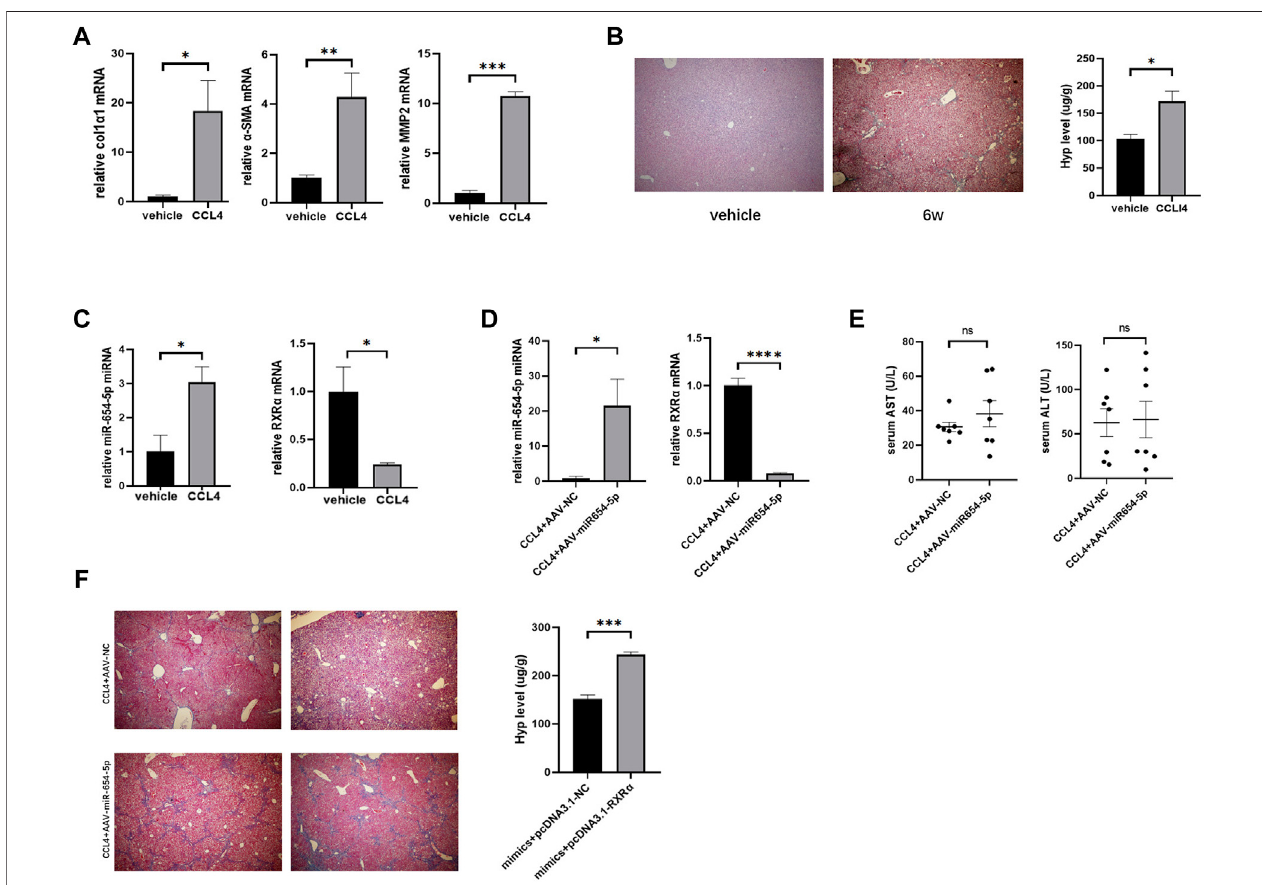
FIGURE 6| MiR-654-5p expression level is increased causing an aggravating effect in CCl4-induced mouse LF, owing to RXR α targeting. (A) col1 α 1, α -SMA, and MMP2 mRNA expression levels in the livers of CCl 4 -treated mice versus vehicle. Quantitative polymerase chain reaction analyses were performed to quantify mRNA expression levels, with β -actin as a loading control (B) After treating with olive oil control (vehicle) or CCl4 for 6 weeks, Masson ’ s trichrome images (40× magni fi cation) and hydroxyproline measurement were used to evaluate liver fi brosis. (C) MiR-654-5p and RXR α levels in liver tissues. U6 was used as a loading control for miR- 654-5p (D) ExpressionlevelsofmiR-654-5pandRXR α ,asquanti fi ed via qPCRanalysisoflivertissuesamples. (E) SerumALTandASTlevelsquanti fi edtodeterminethe extent ofliver damage in the different groups (F) Liver fi brosis evaluated via Masson ’ s trichrome staining and hydroxyproline measurement. Error bars represent mean ± SEM of at least three in dependent experiments. * p < 0.05, ** p < 0.01, *** p < 0.001 and **** p < 0.0001; ns, p ≥ 0.05. CCl 4 , carbon tetrachloride; ALT, alanine aminotransferase; AST, aspartate aminotransferase.